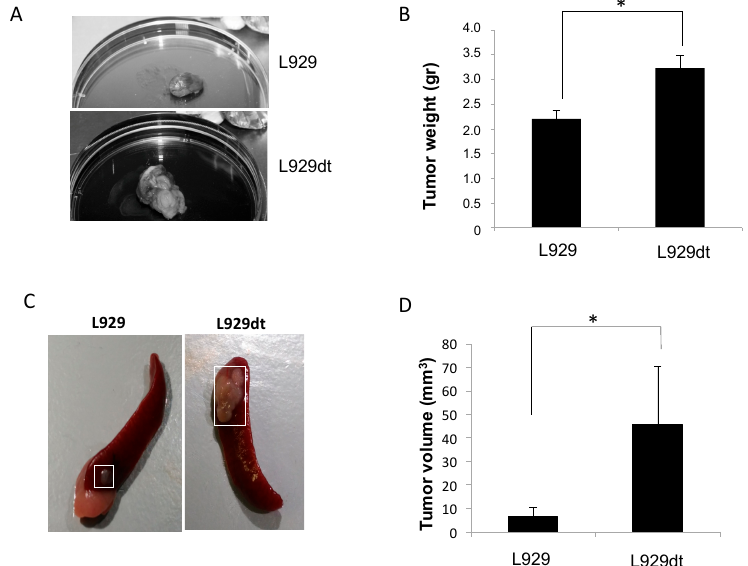
culture form (Figure 5).